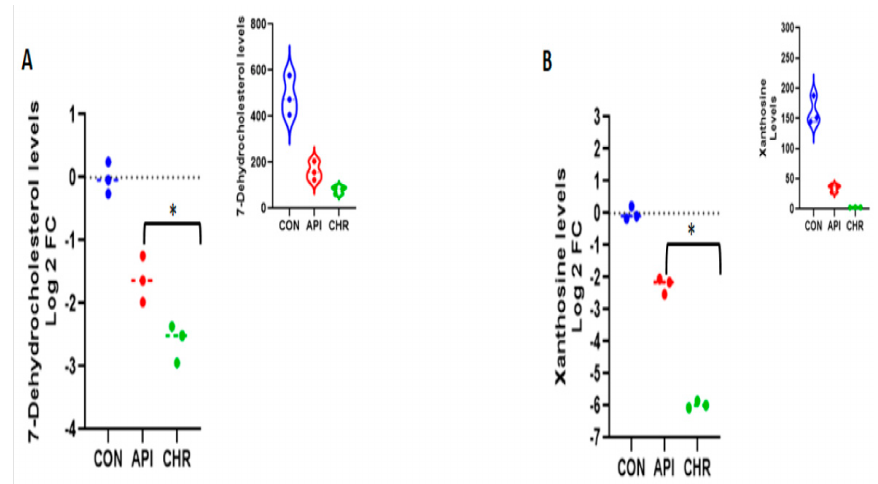
Figure 10. Downregulation of cholesterol and uric acid pathways by apigenin and chrysin: Both apigenin and chrysin demonstrated to have a suppressive effect on the cholesterol biosynthetic pathway and uric acid pathway based on the major metabolites belonging to these pathways. ( A ) 7-Dehydrocholesterol and ( B ) xanthosine levels as determined by raw values (upper inserts) and log2 fold change values as expressed in respective figures with a significance of * p <